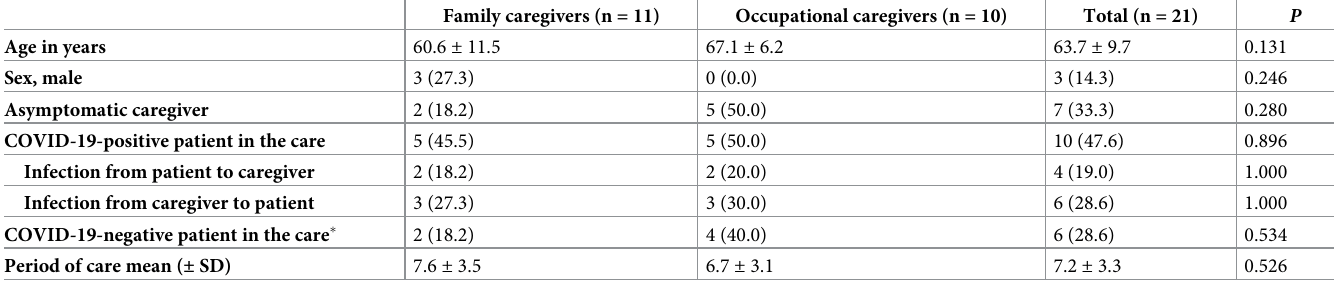
Table 1. Characteristics of caregivers infected with